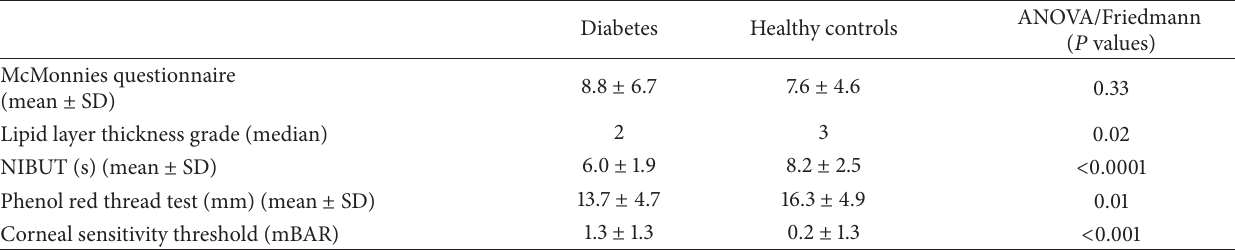
Table 2: Comparison of symptoms and tear characteristics for control and patient groups (mean/median), together with the significance of their differences (ANOVA/Friedmann). Noninvasive tear breakup time (NIBUT) values are extrapolated from logarithmically transformed data.